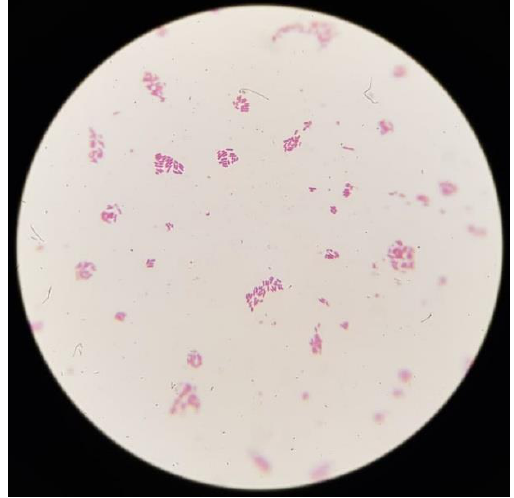
Fig . 3: Arrangement of Actinomyces spp. by Gram’s stain showing Gram-positive filamentous rods